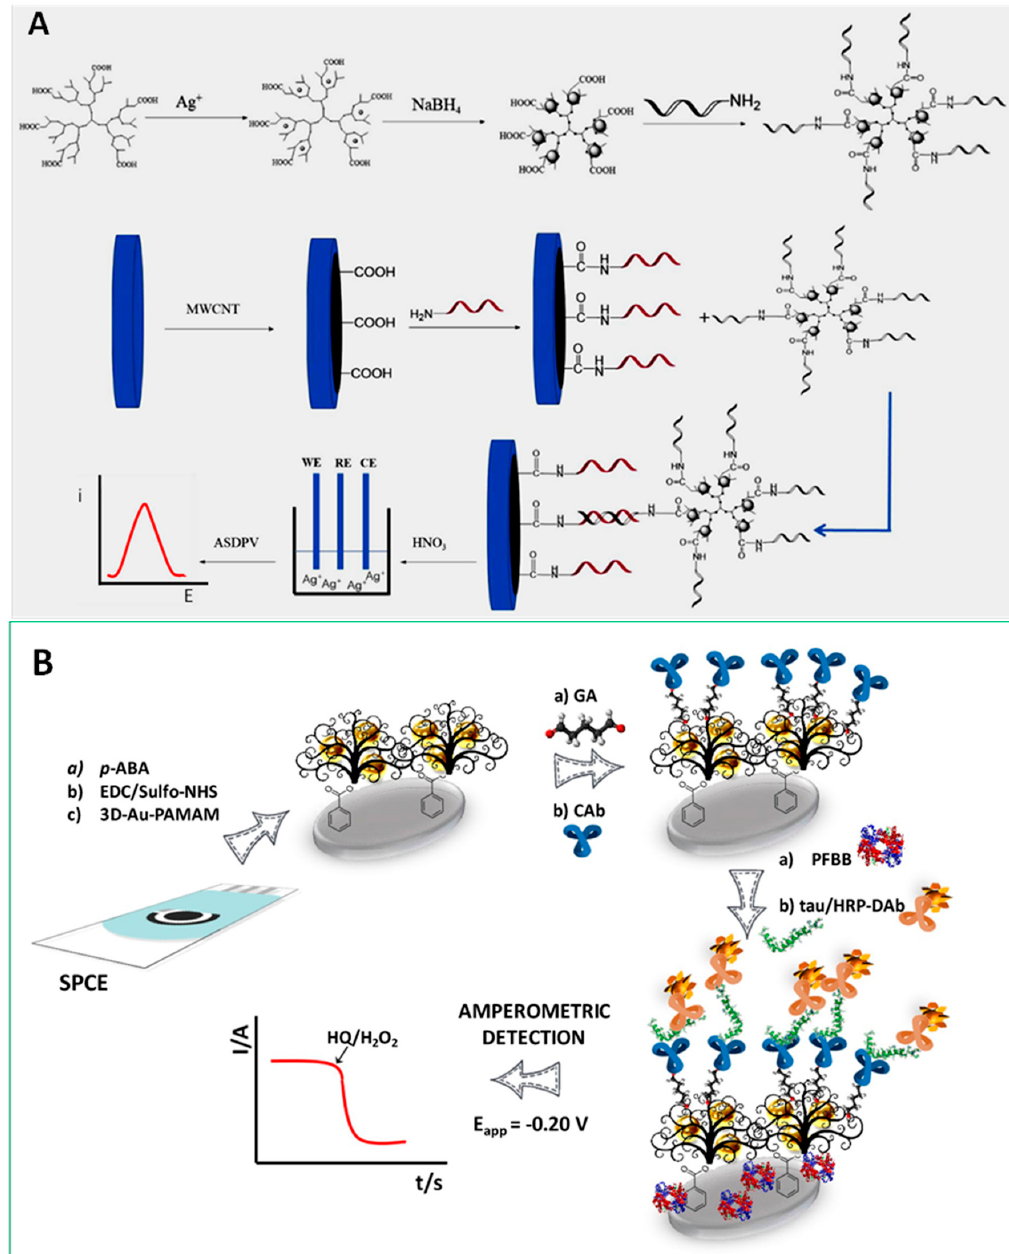
Figure 5. ( A ) Schematic display of the method for the detection of DNA hybridization using Ag-DNCs as label; ( B ) Fabrication and amperometric transduction involved in the development of an HRP- DAb-tau-CAb-3D-Au-PAMAM- p -ABA-SPCE immunosensor for the determination of tau protein. Reproduced from [32] ( A ) and [21] ( B ) with permission. protein. Reproduced from [32] ( A ) and [21] ( B ) with